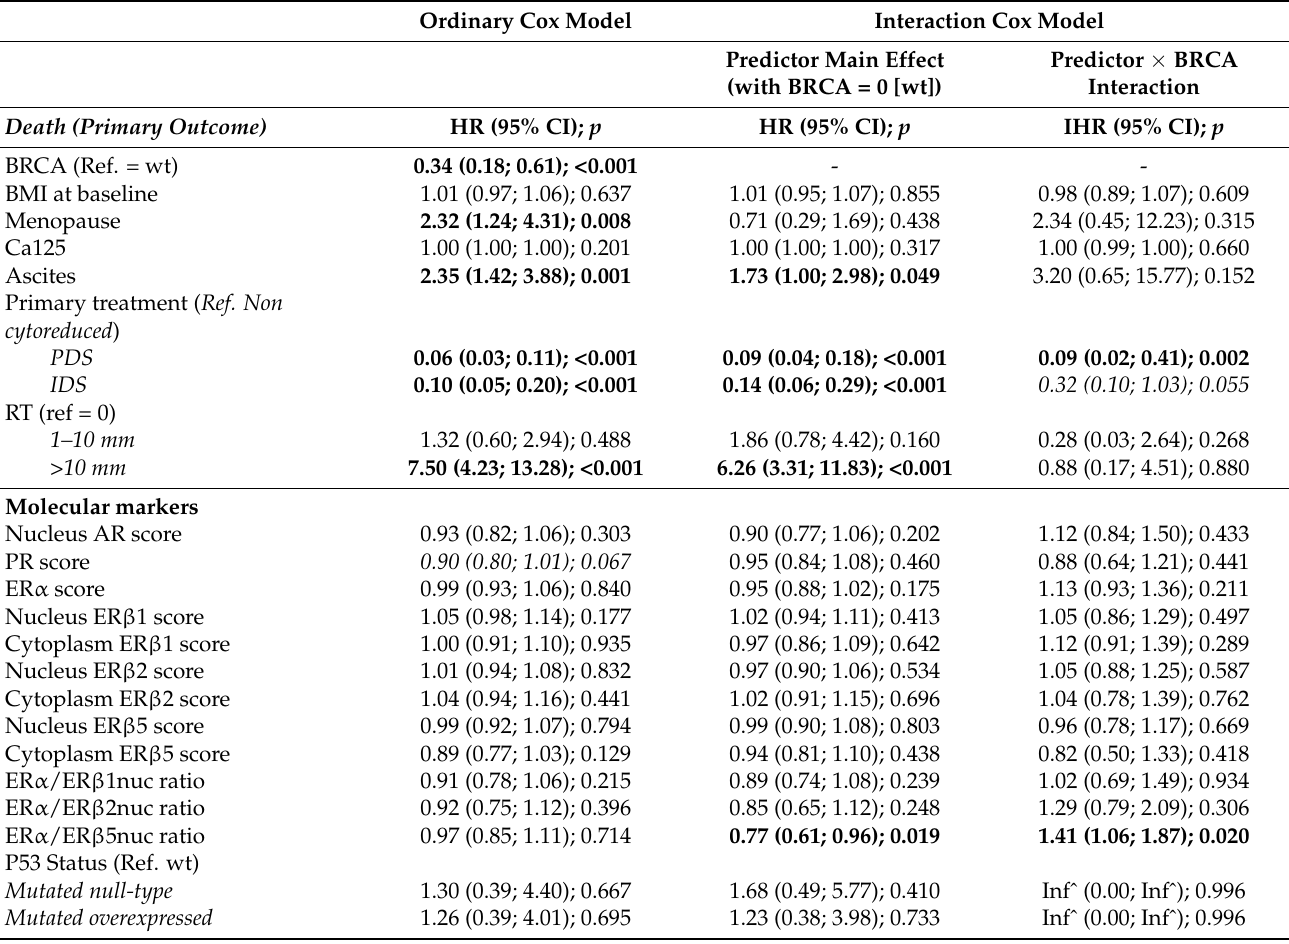
Table 3. Survival Analysis on BRCA-wt vs. BRCA mutated ( n = 207)